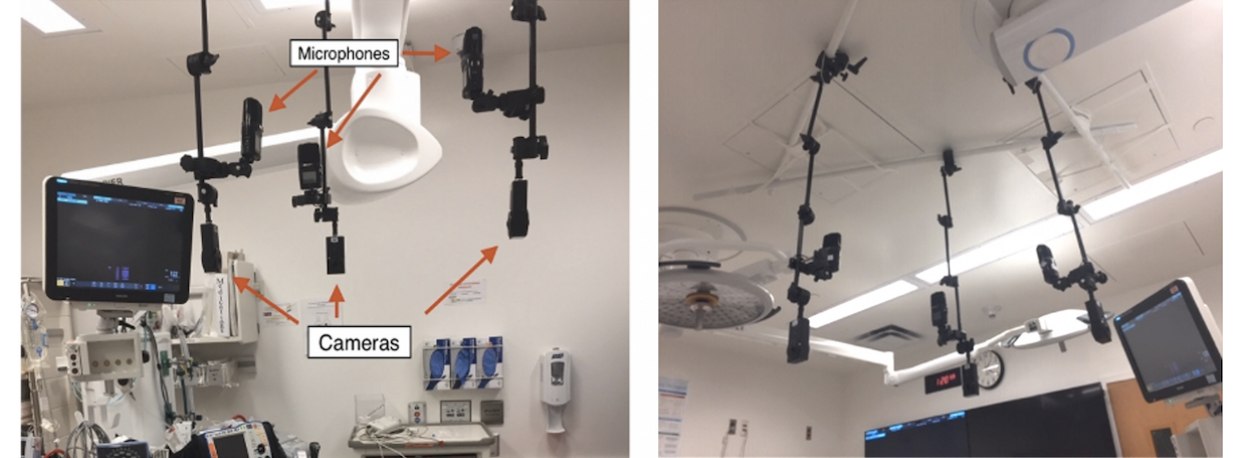
Figure 2. Ceiling camera configuration.